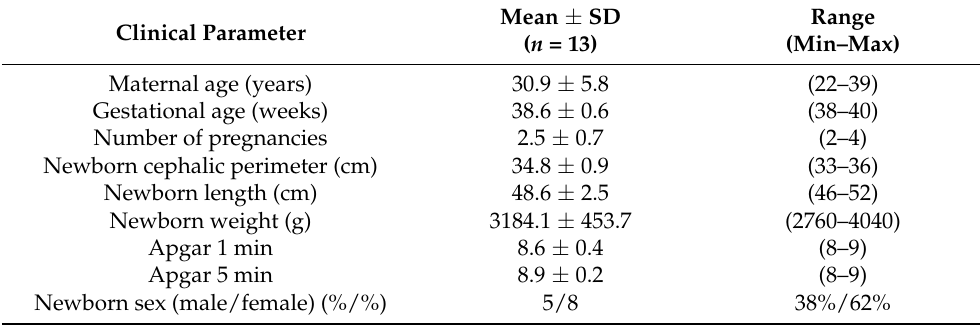
Table 1. Clinical data of mothers and